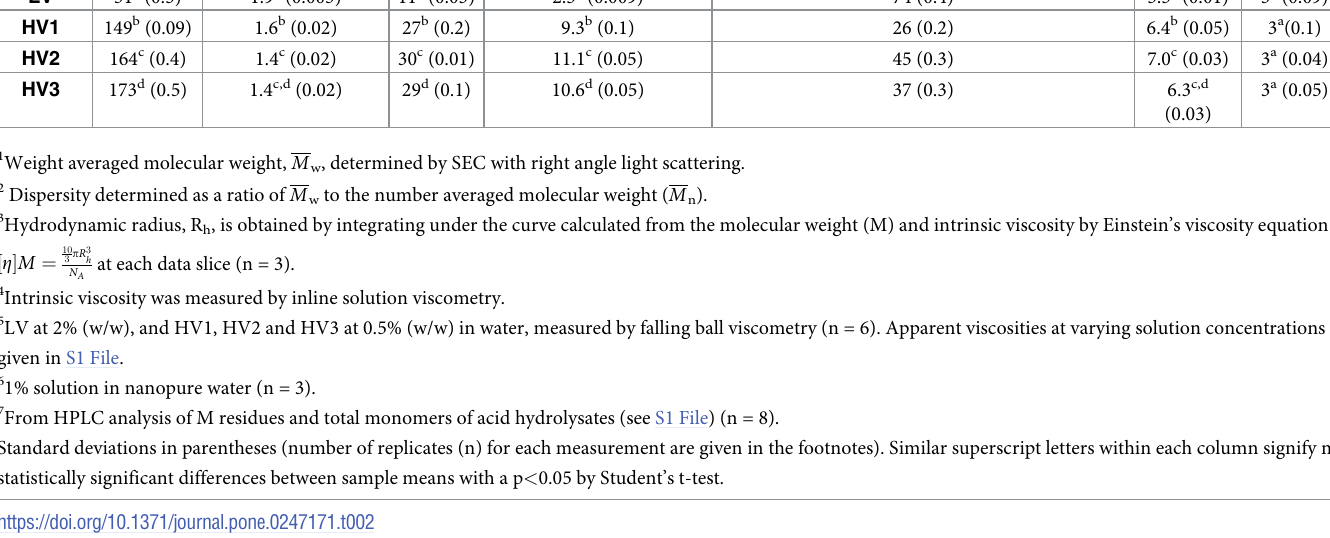
Table 2. Properties of alginates used in this study (commercial source of alginates provided in Table 1). Sample